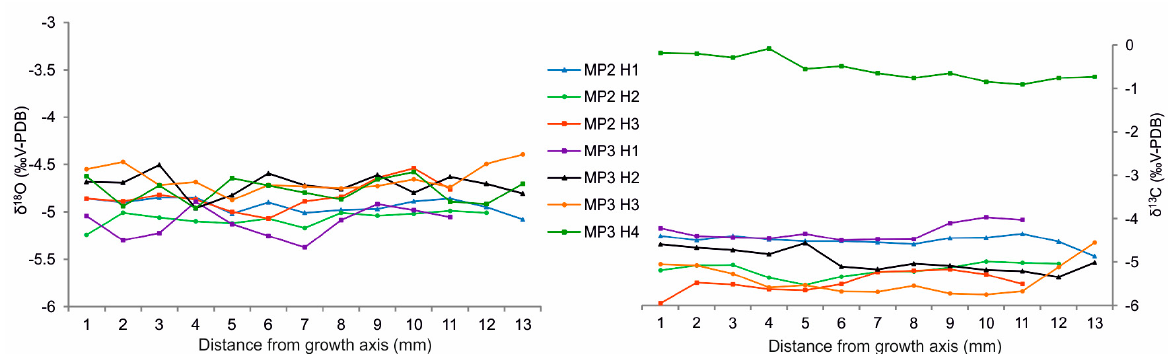
Figure A1. δ 18 O and δ 13 C values along the MP-2 and MP-3 growth layers selected for the Hendy tests [6]. For the location of the sampling tracks, see Figure 2. Equilibrium deposition is presumed due to the lack of a significant trend in the isotopic ratios towards heavier isotopic values away from the growth axis.